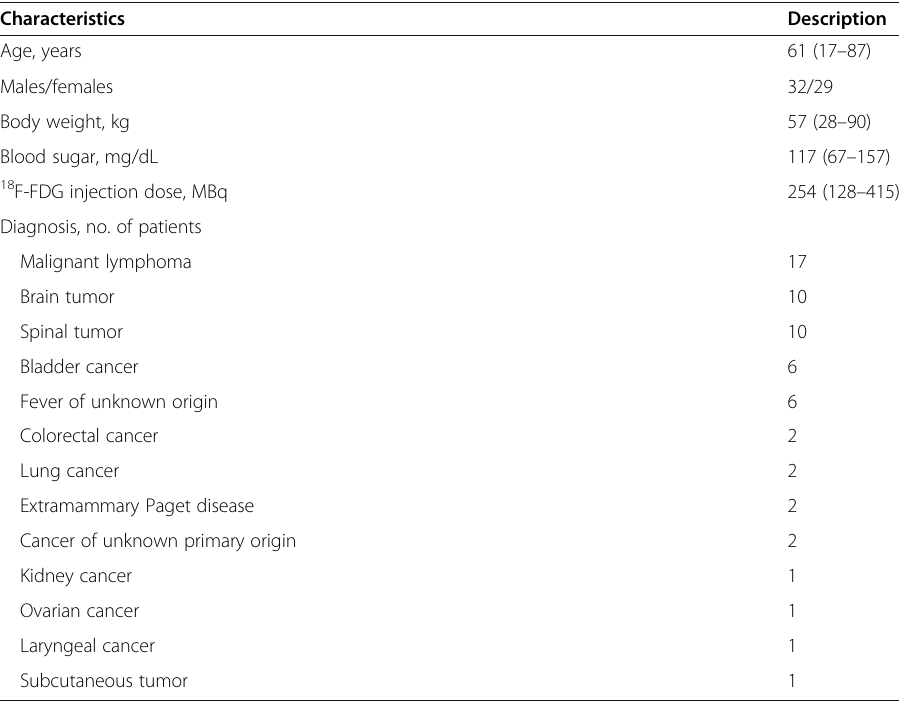
Table 1 Background of the 61 patients with urinary catheters Characteristics